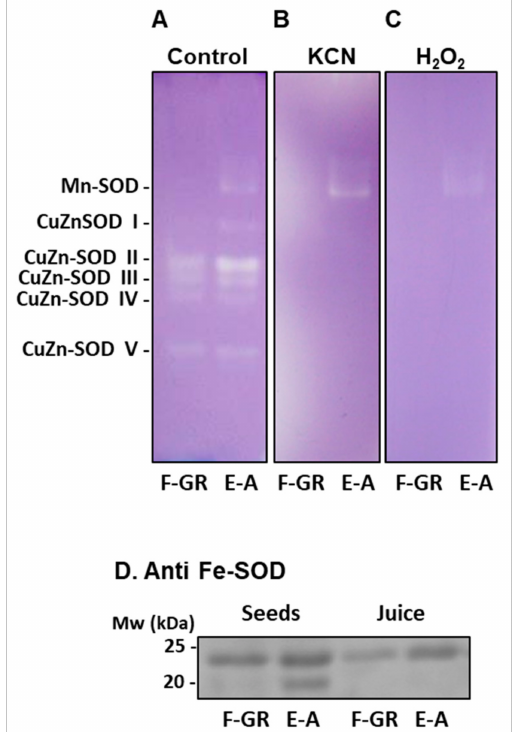
Figure 2. Superoxide dismutase (SOD) isozymes from seeds of two Spanish pomegranate populations. SOD activity was analyzed by non-denaturing PAGE on 10% acrylamide gels. After electrophoresis, enzyme activity was detected in gels by the NBT photochemical method under control conditions ( A ) and under the presence of specific inhibitors, either 5 mM KCN ( B ) or 5 mM H 2 O 2 ( C ). One Mn-SOD and five CuZn-SODs (I–V) were identified. ( D ) Western blotting was carried out using an antibody against Fe-SOD from pepper fruits (dilution 1:1000). Molecular weights are indicated on the left. Pomegranate fruits from El Fargue, Granada (F-GR) and Elche, Alicante (E-A) were